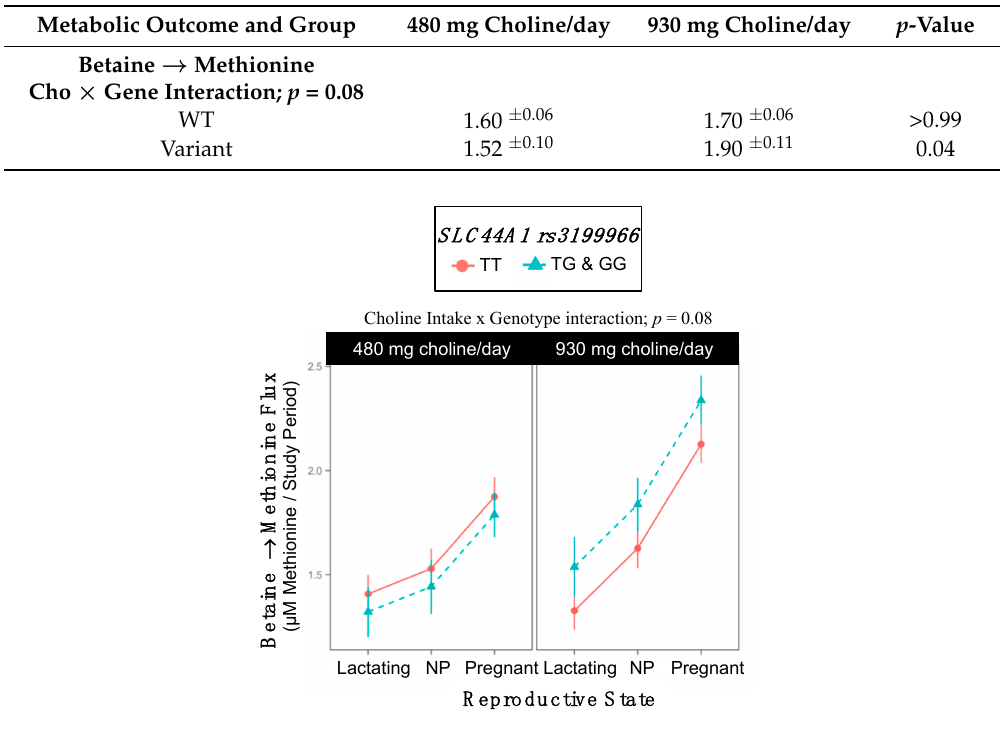
Figure 10. Effect of the SLC44A1 rs3199966 variant on the metabolic flux and partitioning of dietary choline.